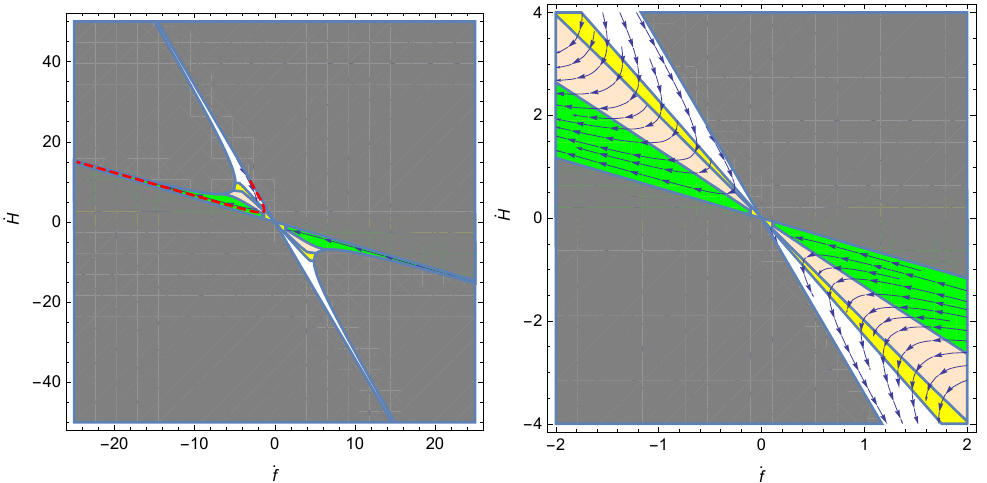
Figure 4 . The (cid:13)ow of solutions with e (cid:0) 2 f = X + : the red dashed line represents a solution curve shown in (cid:12)gure 5. This is the same (cid:13)ow solution in (cid:12)gure 3 except the size of the parameter space ( _ f; _ H